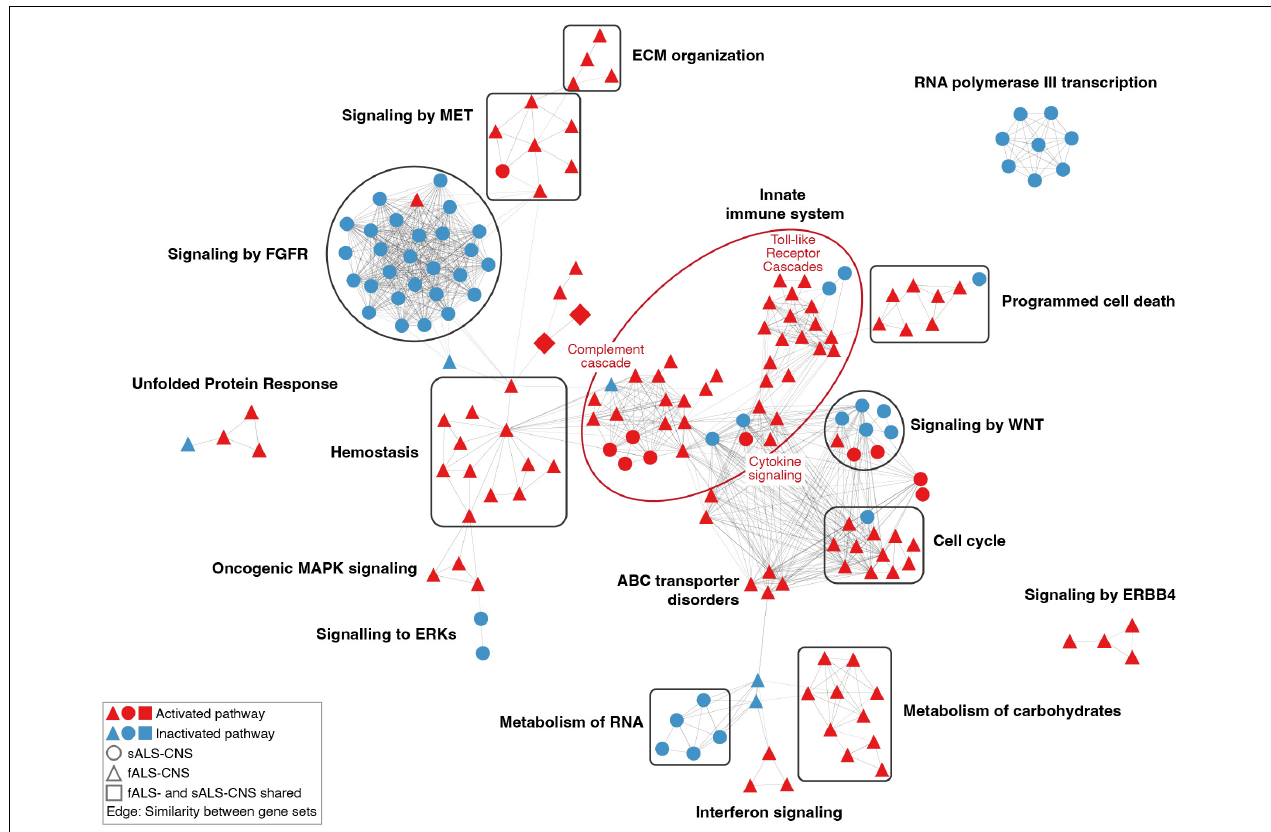
FIGURE 3 | Network of dysregulated pathways in CNS comparisons. Each node represented a dysregulated pathway consisting of a set of genes. Nodes with similar gene contents (similarity coefficient > 0.35) were connected by edges, and the thickness of node-linking edges was proportional to the similarity between a pair of gene sets. Clusters of pathways were annotated based on the hierarchical level of pathways retrieved from the Reactome database. The constituent pathways of a cluster were colored in red or blue for activation or inactivation. Only clusters containing more than three pathways were